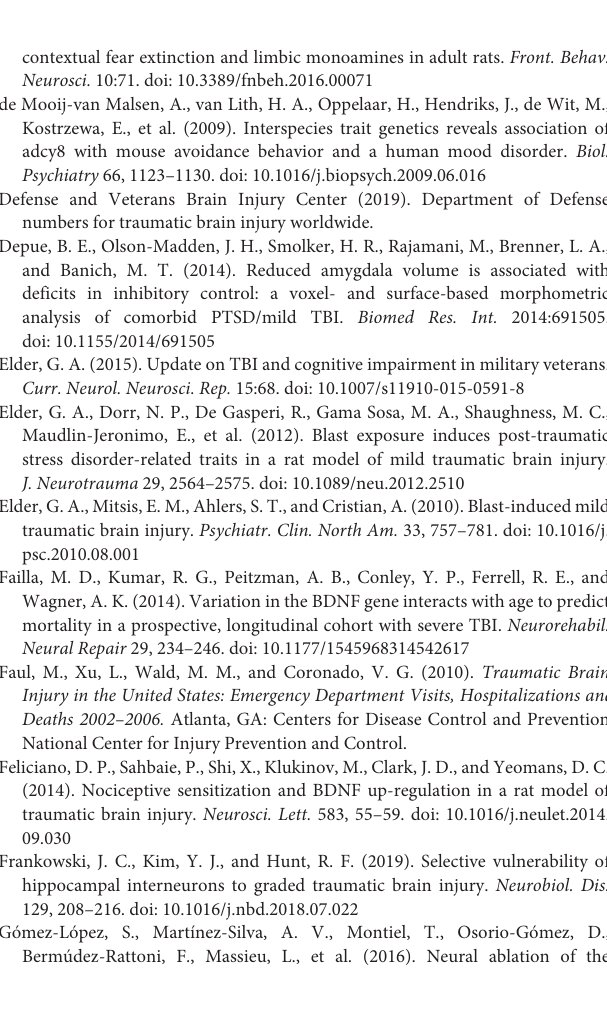
FIGURE S1 | Additional behavioral testing results. (A) Time spent in the light side of the light/dark box in the sub-acute cohort. (B) Time spent in the light side of the light/dark box in the chronic cohort (error bars represent